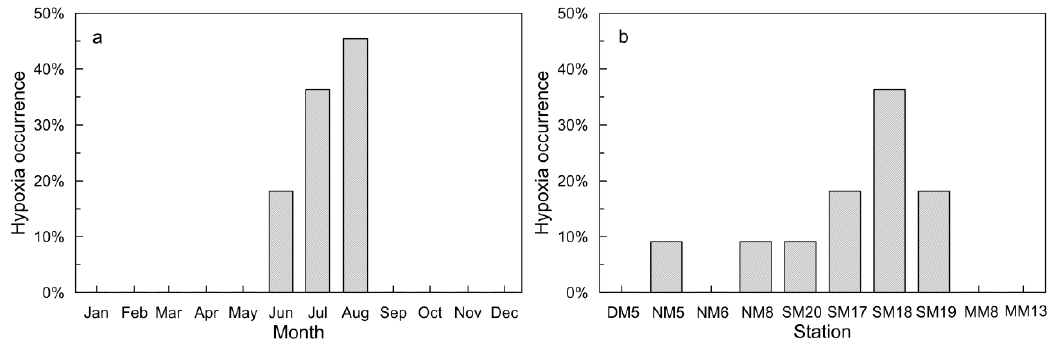
Figure 9. Variability of bottom hypoxia occurrence during the period 2000–2017. ( a ) Average in each month; ( b ) average at each station.